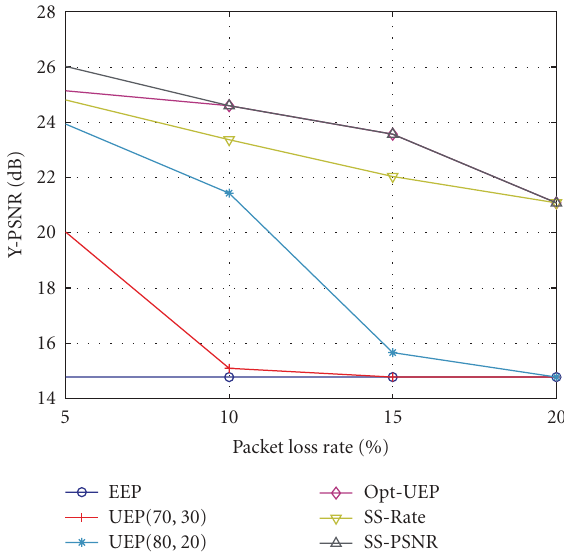
Figure 3: PSNR versus PLR at overall data rate of 1.1 Mbps for the “Football” sequence—Uniform Loss.